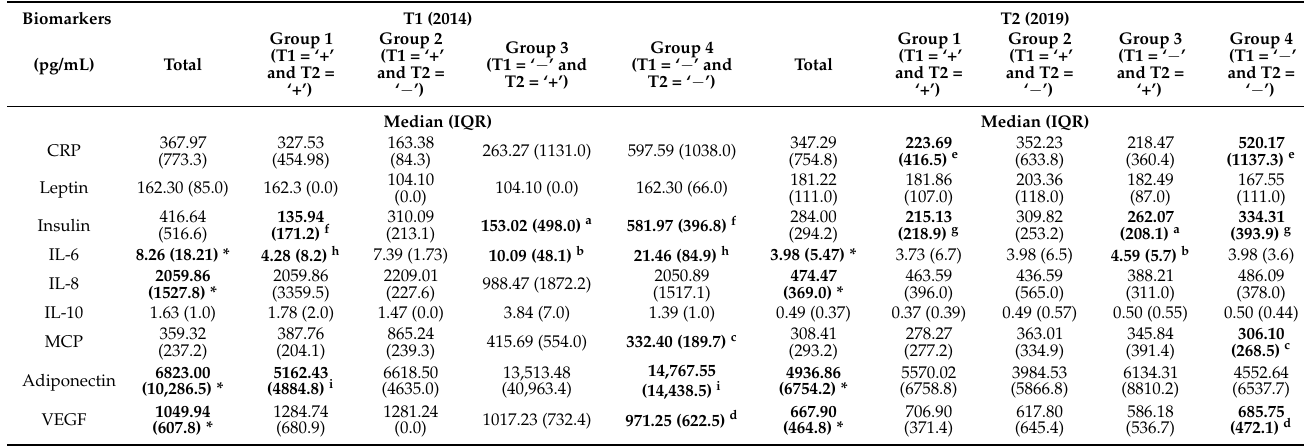
Table 4. Median and inter-quartile range (IQR) for salivary biomarkers at T1 and T2 for the metabolic categories.